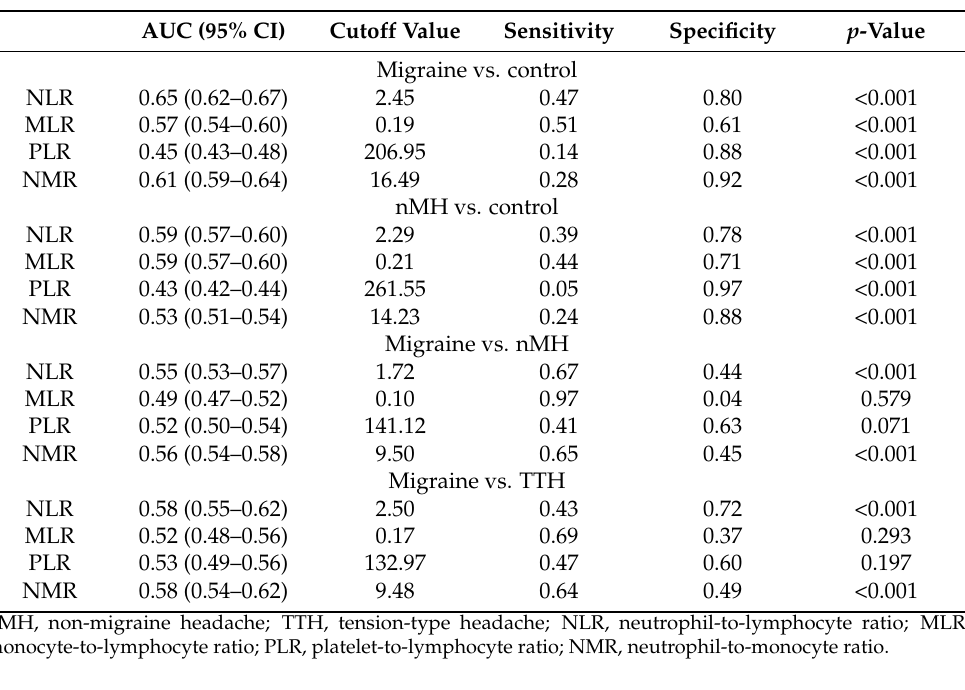
Table 8. AUC and optimal cutoff values of inflammatory markers for differentiating between groups.